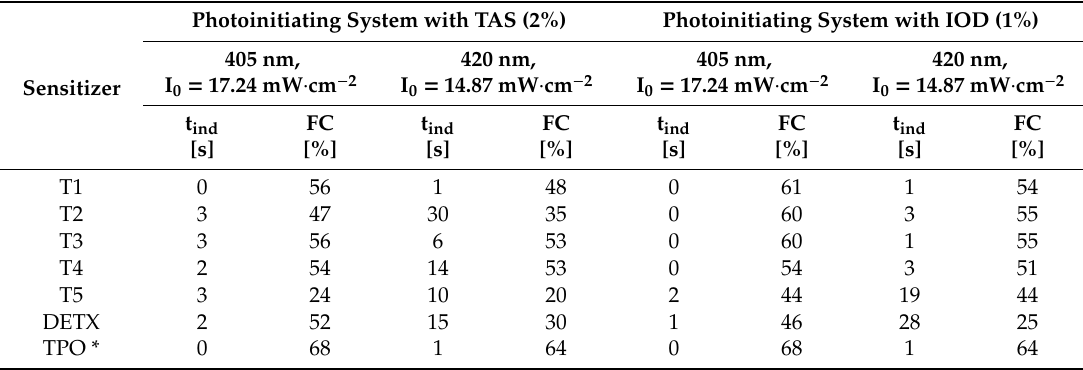
Functional group conversions of acrylate monomer TMPTA using a photoinitiating systems based on 2,4-diethyl-thioxanthen-9-one derivatives (5.3 × 10 − 3 mol · dm − 3 , ~0.2% wt.) and bis(4- t -butylphenyl)iodonium hexafluorophosphate (IOD 1% w / w ) or